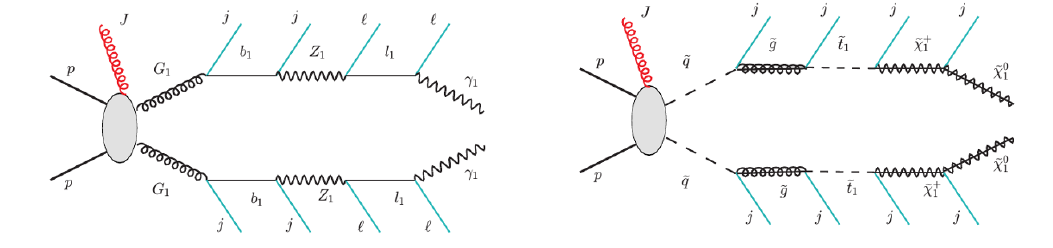
Figure 1 . A sample of the relevant topologies in both MUED and MSSM scenario. J refers to the initial hard jet which triggers the event. j and ‘ refers to soft jets and leptons which gives rise to tracks at the (cid:12)nal